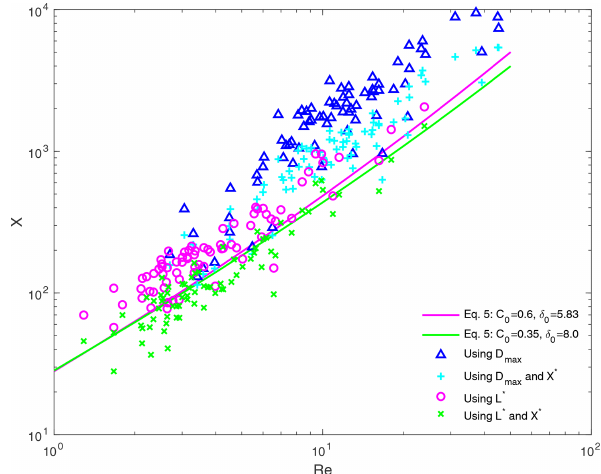
Figure C2. X vs. Re and X ∗ vs. Re for simple thick columns se- lected from shape group (3) Thick columns . X and Re are deter- mined using either D max or L ∗ . The points X vs. Re using L ∗ are much closer to the empirical relationship (Eq. 5) than the points us- ing D max . Using the modified Best number X ∗ instead of the Best number X leads to a better agreement with Eq. (5). For comparison, the empirical relationship given by Eq. (5) is shown with parameters from Böhm (1989) and Heymsfield and Westbrook (2010), respec- tively. They are, however, very